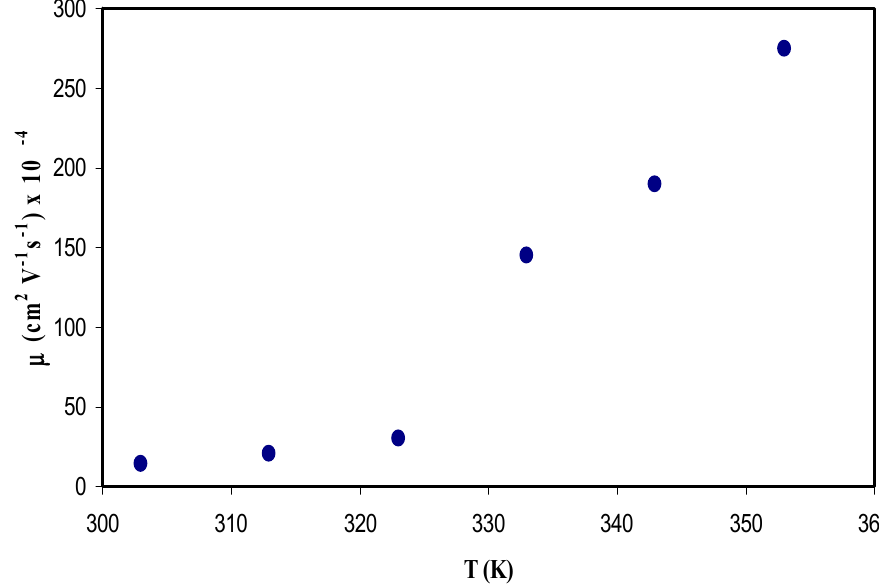
µ ) versus temperature for the CS: POZ: MgTf Figure 13. Ion mobility ( μ ) versus temperature for the CS: POZ: MgTf system. Figure 13. Ion mobility (